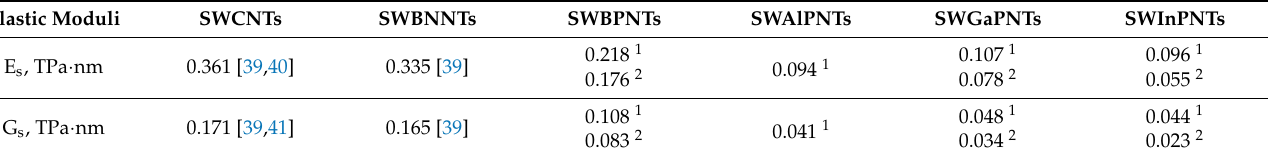
Table 9. Surface elastic moduli of carbon, boron nitride and phosphide single-walled nanotubes. Elastic Moduli